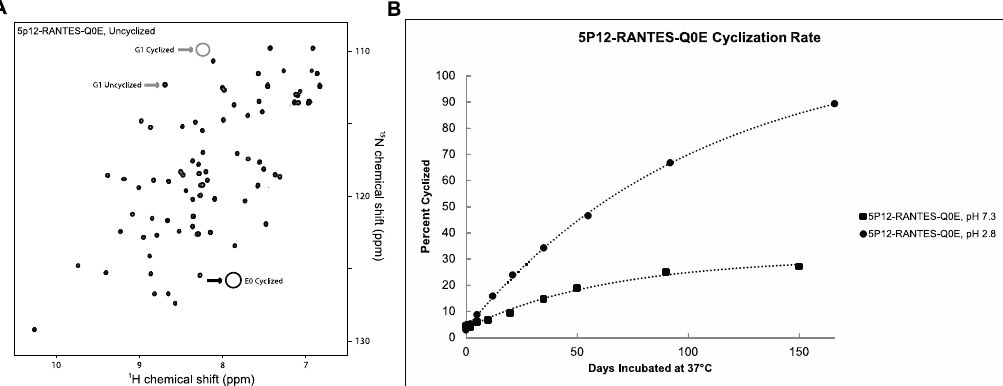
Figure 4. 5P12-RANTES-Q0E. ( A ) HSQC spectrum of 15 N-labeled 5P12-RANTES-Q0E. The spectrum is identical to that of 5P12-RANTES except for a slight G1 shift (grey arrows) and a loss of two side chain amide peaks corresponding to the Gln-0 NH 2 group and no cyclized peak (black arrow, circled, lower right). Cyclization results in a shift of the G1 residue (labeled) which can be used to quantify the amount of cyclized 5P12-RANTES-Q0E in solution. Spectrum was measured in 20 mM sodium phosphate, pH 2.8, 25 °C. Percent cyclization was measured by peak height at lower contour levels than shown. ( B ) Cyclization over time of 5P12-RANTES-Q0E in pH = 7.3 and pH = 2.8, incubated at 37 °C. Spectrum at the 150 day time point shows folded protein, with some degradation (Figure S2).